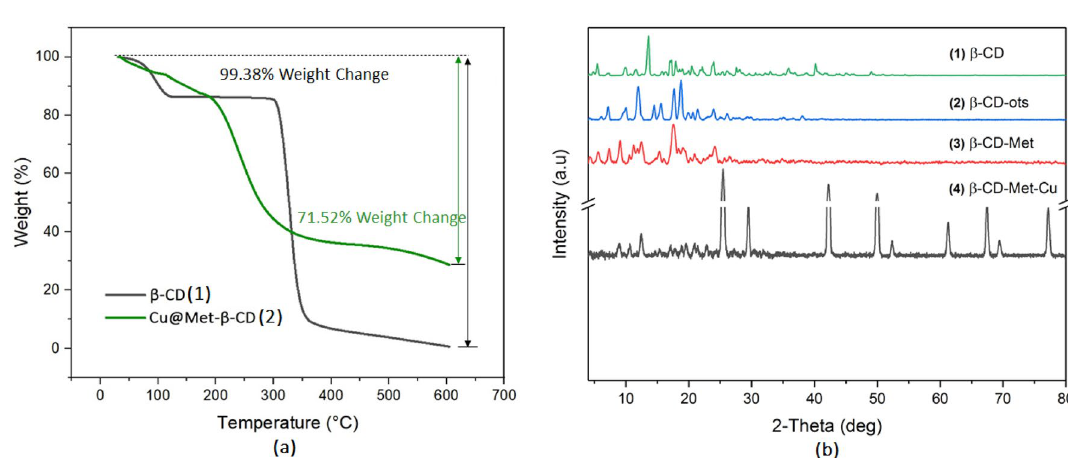
Figure 4. SEM images of Cu@Met-β ‐ CD.